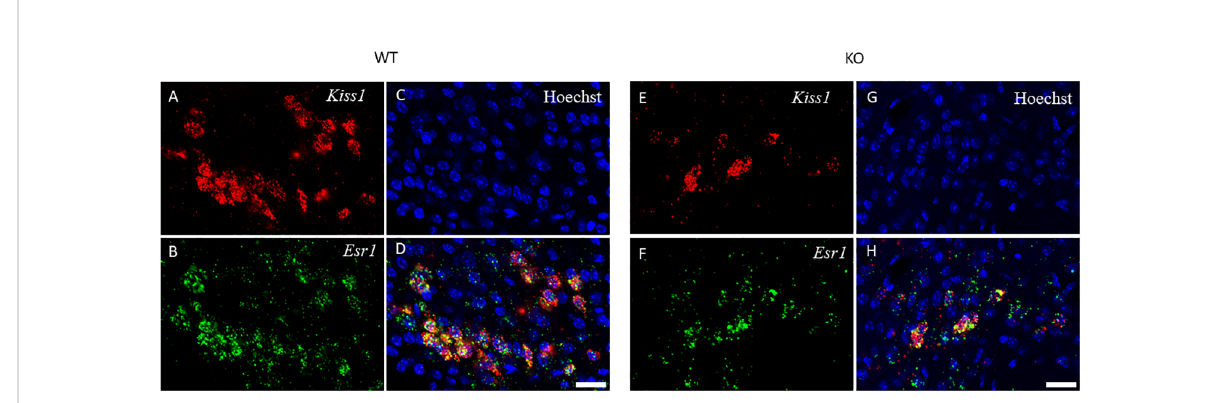
FIGURE 6 Kiss1 and Esr1 mRNA expression in the ARC of wild-type and PACAP KO female mice. The expression of Kiss1 (panels A, E ) and Esr1 (panels B, F ) mRNAs in the ARC of WT and PACAP KO mice is depicted in representative confocal images. Nuclear counterstain with Hoechst33342 and the merged image are presented in panels C, G and D, H respectively. 20× magni fi cation, scale bar: 25 µm.